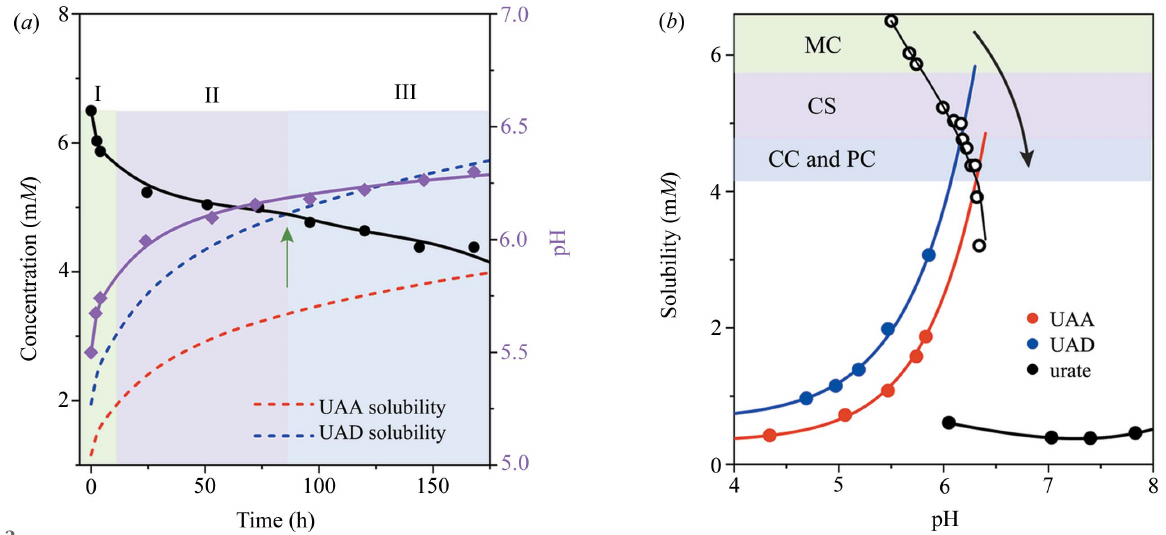
Figure 3 Crystallization kinetic profiles and phase diagram. ( a ) Time-resolved depletion profile of the urate concentration (black circles) and the corresponding pH (pink circles) evolution profile in solution crystallized from a 6.5 m M urate concentration at an initial pH of 5.5. The lines are interpolated to guide the eye. The blue-dashed line represents the solubility of UAD measured and interpolated from experimental data (Fig. S4). The red-dashed line represents the solubility of UAA measured and interpolated from experimental data (Fig. S4). ( b ) Phase diagram of the urate crystallization with respect to solution pH. The black, red and blue points are the measured solubilities of urate sodium monohydrate, UAA and UAD, respectively, and the corresponding lines are interpolated to guide the eye. The black empty circles represent the time-resolved depletion profile of the urate concentration, and the corresponding line is interpolated to guide the eye, representing the dynamic operating line over